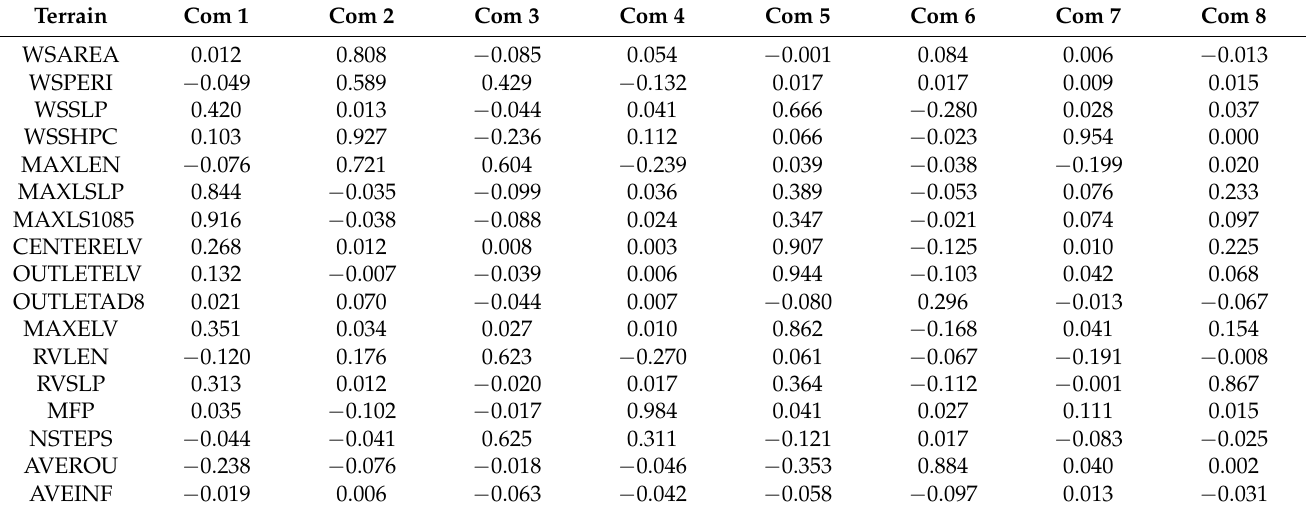
Table 7. Results of Analysis of Terrain Factors.